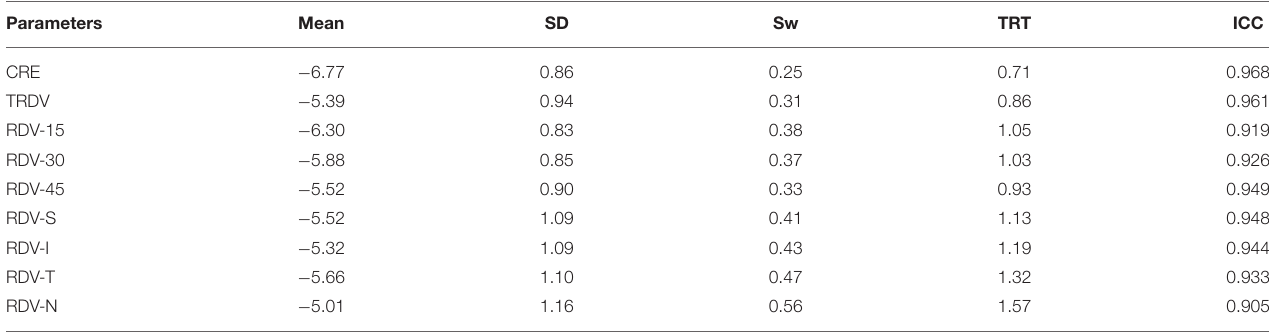
TABLE 8 | Intraobserver repeatability outcomes of central and peripheral refraction using MRT with cycloplegia of high myopia group. Parameters